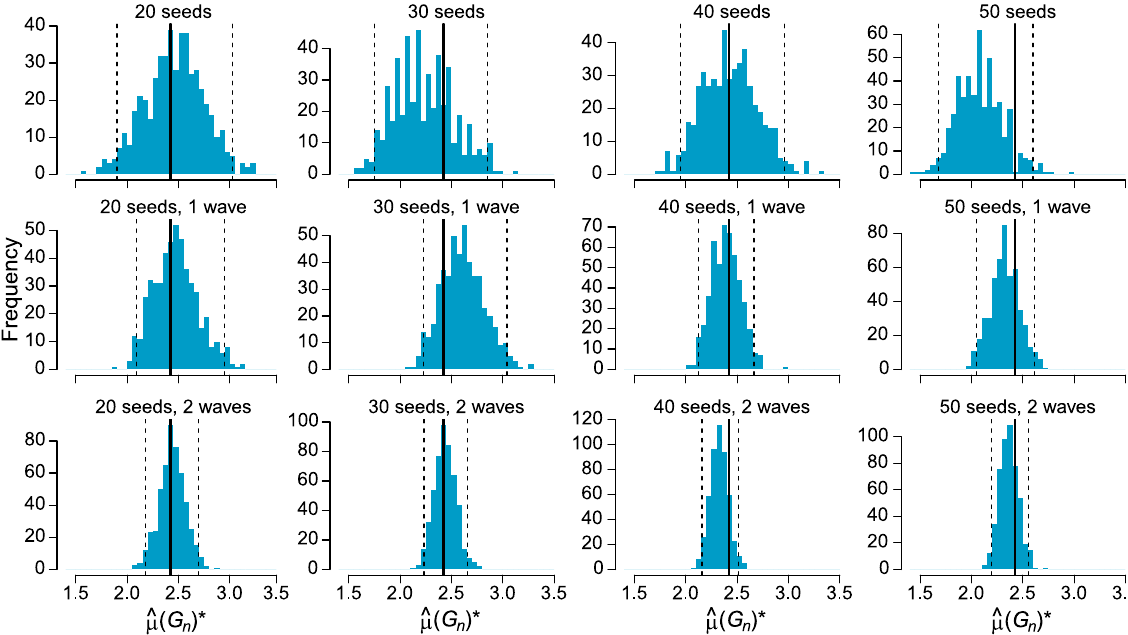
for a simulated network of order 10,000 with n